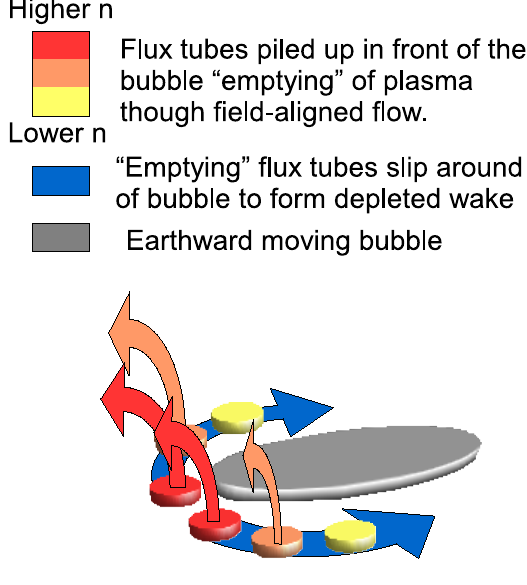
Fig. 14. An illustration of the suggested formation mechanism of the depleted wake. The bubble is grey while the flux tubes that pile up in front of it are colour-coded red-orange-yellow with decreasing plasma content near the equatorial plane. Arrows of the correspond- ing colour represent the field-aligned plasma flow that “empties” the flux tube. Blue arrows mark the motion of the emptied flux tubes as they slip around the sides of the bubble forming the